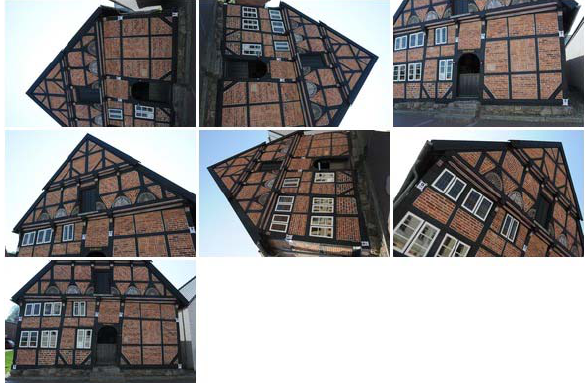
Figure 10. Overview of 7 photographs used for automatic texture mapping of the 3D facade of the town house (Bürgerhaus) in Bad Segeberg